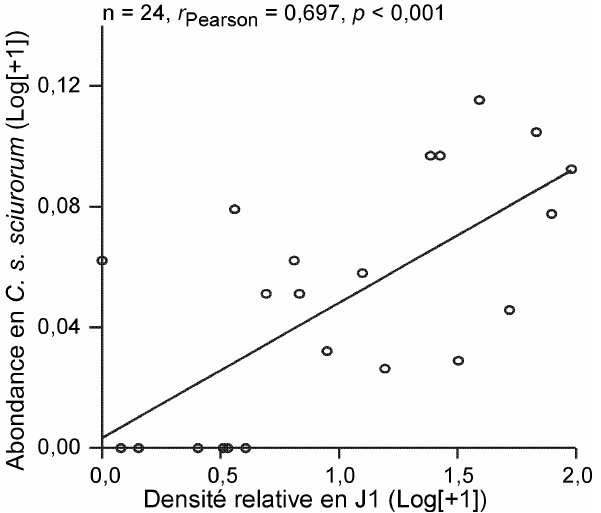
Fig. 5. – Relation entre les abondances en C. s. sciurorum et les den- sités en tamias juvéniles de la première cohorte (J1) capturés de mai à novembre en Forêt de Sénart en 2004 et